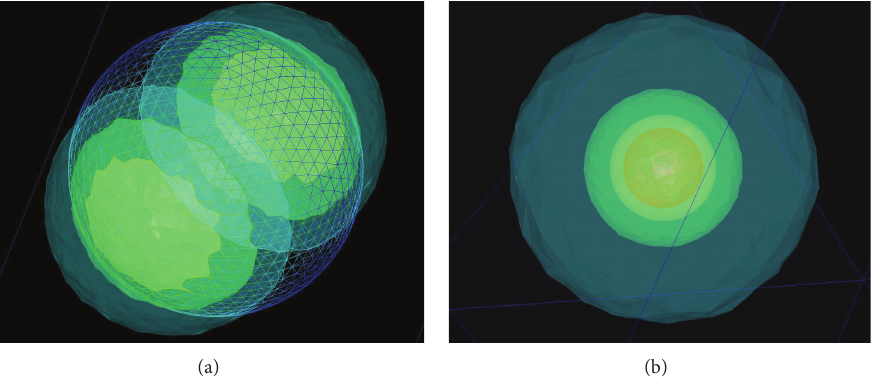
Figure 8: Isosurfaces of the intensity of electric field (a) and temperature (b) associated with the initial mesh ( 𝑁 0 = 289 605 elements).